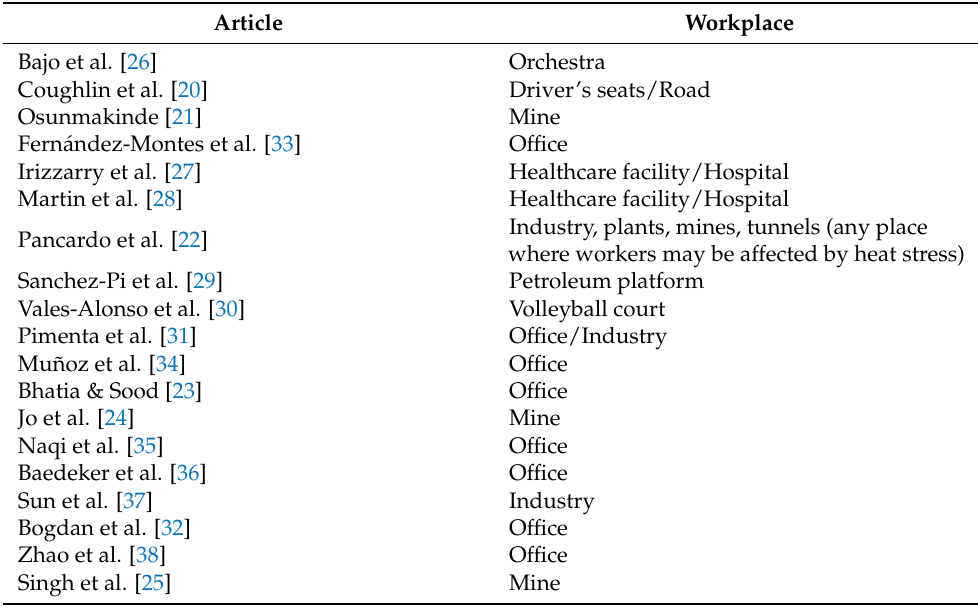
Table 4. Articles paired with the type of workplace they were focused